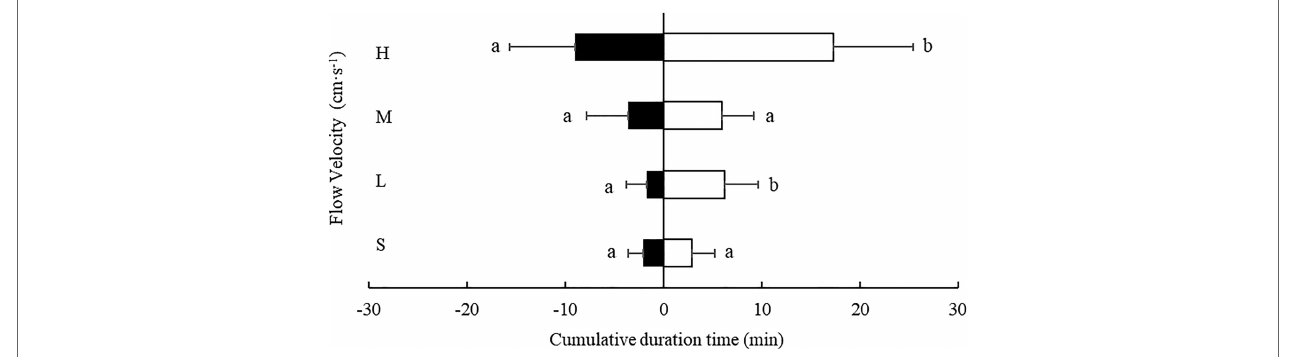
FIGURE 9 | Cumulative residence time of S. monotuberculatus at four water velocities in the downstream (white) and upstream zones (black) at four different flow. S, L, M, and H represent the four flow rates: 0 cm/s, 4.7 ± 1.2 cm/s, 10.5 ± 1.7 cm/s, and 20.8 ± 3.4 cm/s respectively.